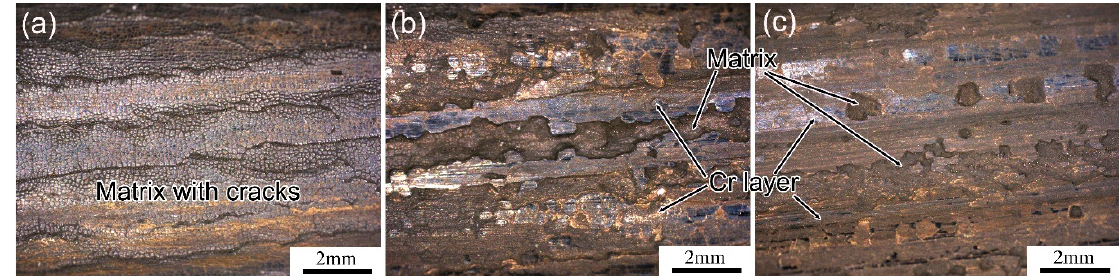
Figure 5. Longitudinal profile morphologies of MG2: ( a ) the part close to the tail; ( b ) transitional part; and ( c ) the part close to MG3.